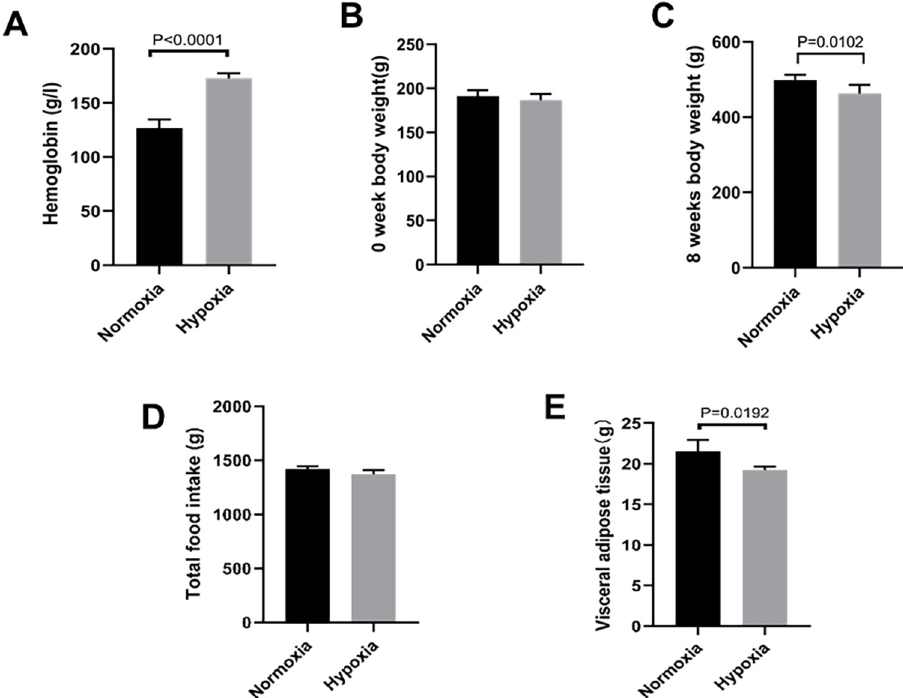
Fig 1. Changes in body weight, adipose tissue, and blood indexes in the hypoxia group versus the normoxia group. Hemoglobin, (B) 0-week body weight, (C) 8-week body weight, (D) total food intake, (E) visceral adipose tissue weight. A: n = 5 rats per group. B-D: n = 6 rats per group. E: n = 4 rats per group. Independent-samples t-test was used for statistical